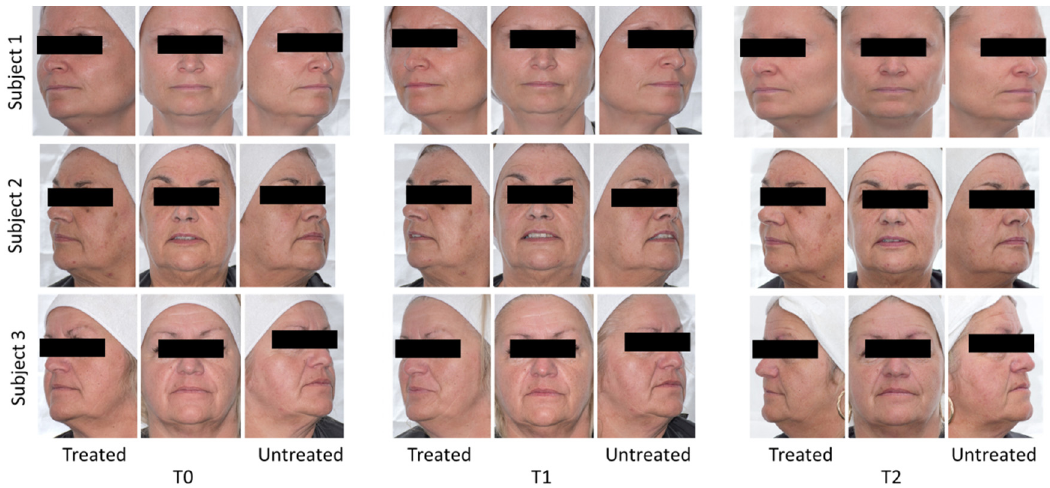
Figure 7. Representative images of three clinical trial subjects at baseline (T0), after one application (T1) and after 4 applications (T2) of the test product. Treated (left profile) and untreated (right profile) sides are shown.